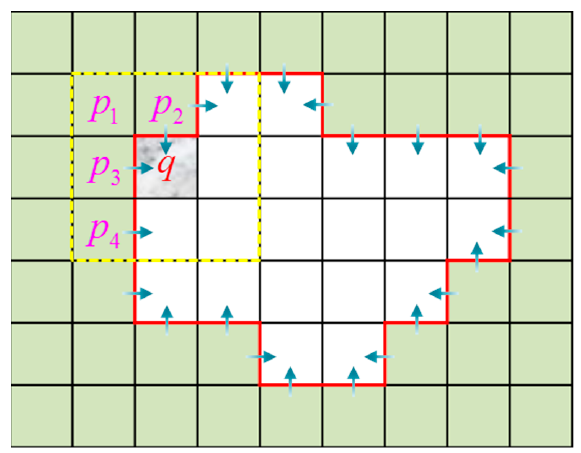
Figure 2. Abnormal displacement correction. Concretely, supposing q is the position of an abnormal displacement, it will be cor- rected with p i in its neighborhood (cid:60) q . There is an assumption that the displacement variation is locally small in (cid:60) q [37,38], as shown in Figure 3. As seen, taking part of the displacement field, owning 21 × 21 pixels, the displacement is displayed with yellow arrow every 5 pixels. Except the abnormal displacements in the lower right corner, the displacement variation is locally small in both magnitude and direction, which is consistent with the continuous law of remote sensing image. Under this circumstance, the